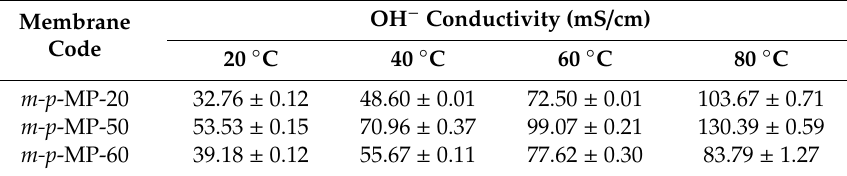
Table 2. Conductivity values of m-p -MP-y copolymer membranes.